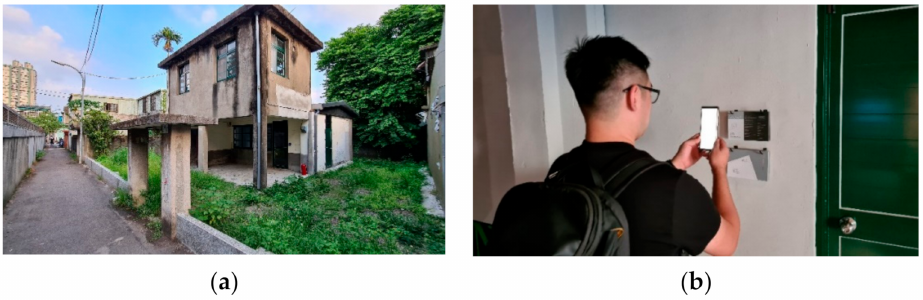
Figure 2. ( a ) 9 Art Space exhibition building; ( b ) AR scanning of artwork